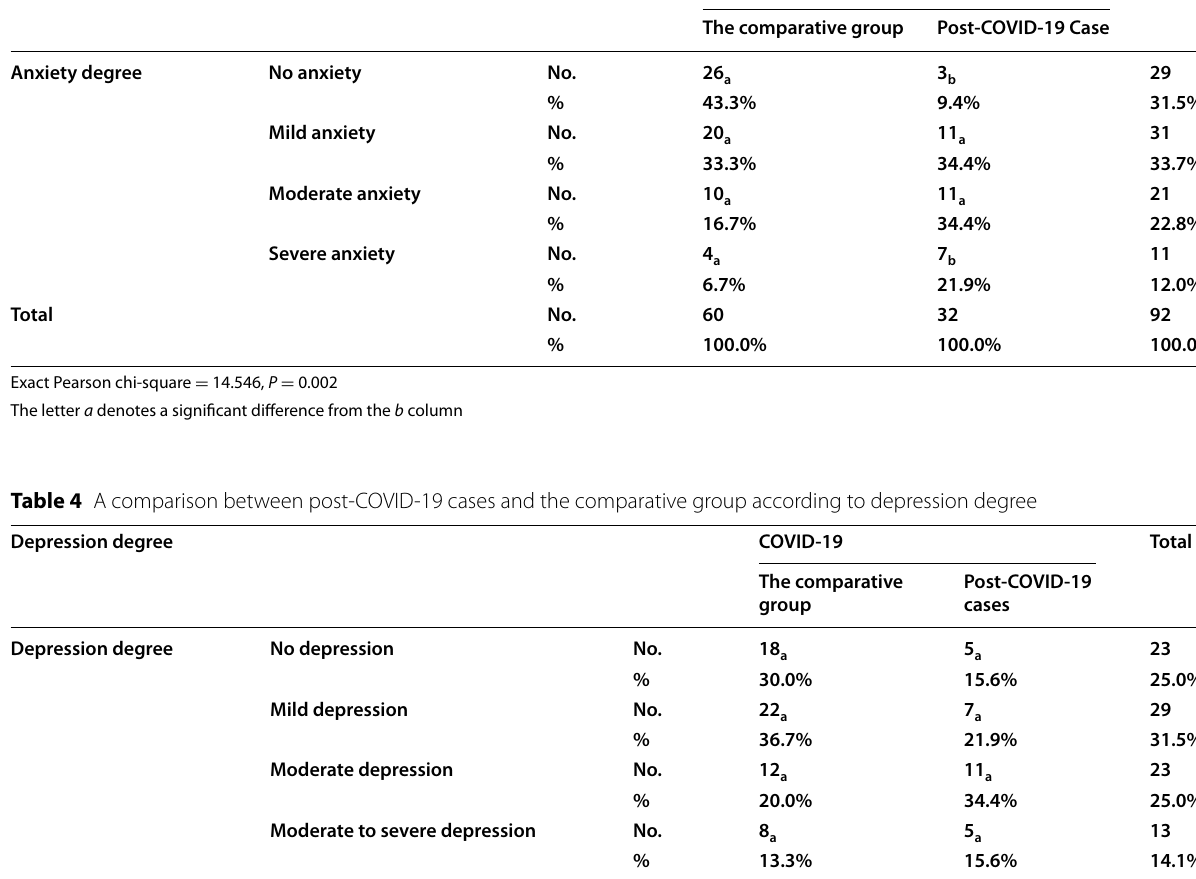
Table 3 A comparison between post‑COVID‑19 cases and the comparative group according to anxiety degree